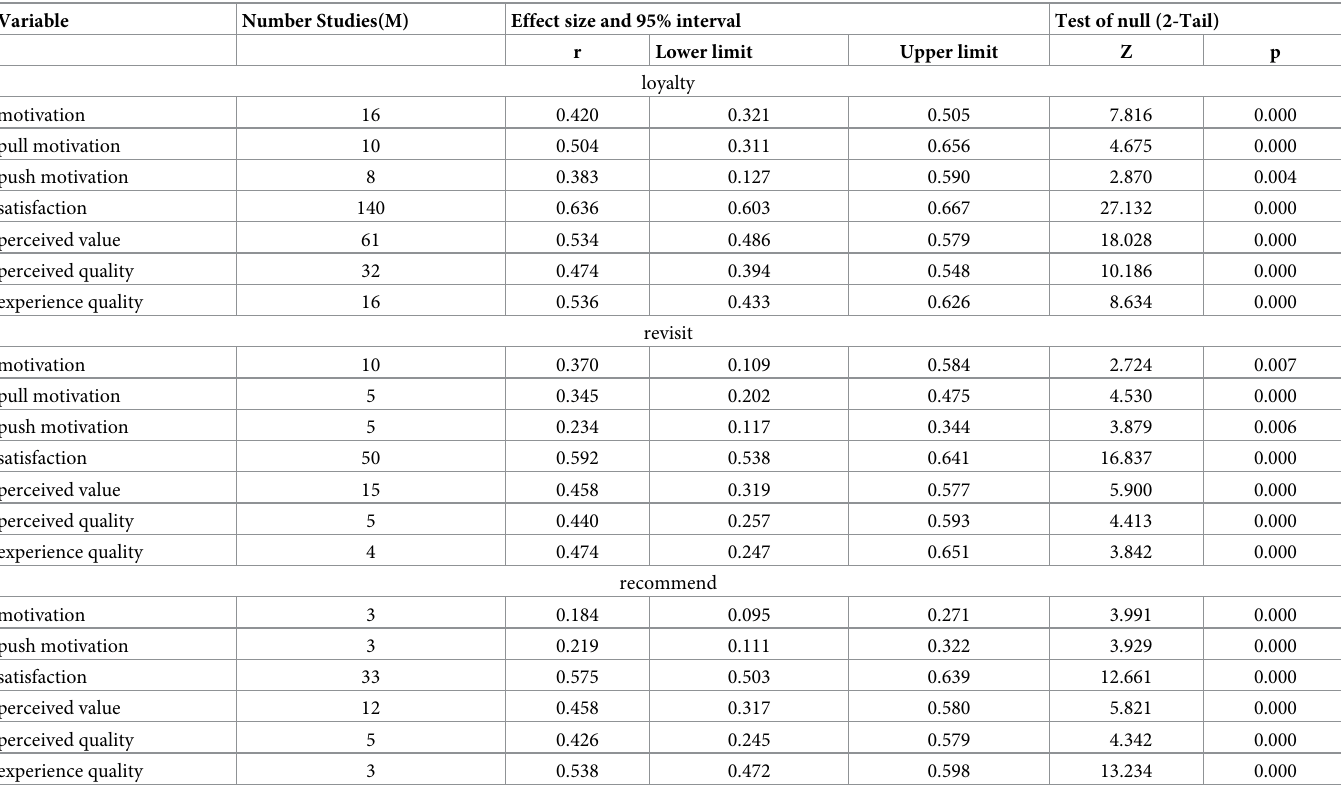
Table 2. Results of effect combination